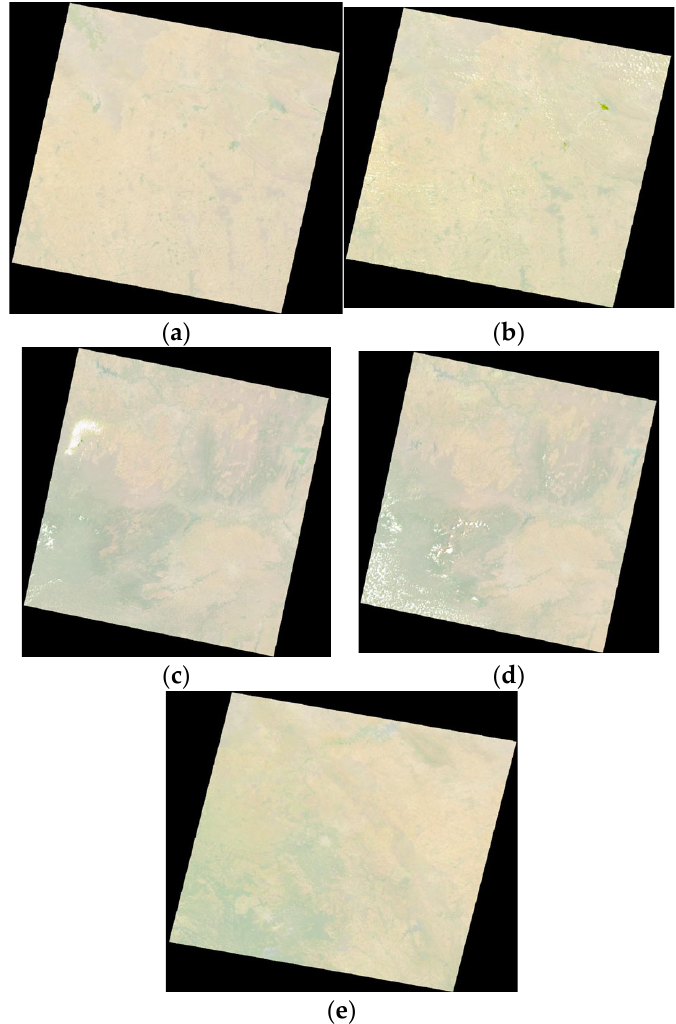
Figure 2. Samples for critical type of images ( a ) Dryland image ( b ) Capillary moisture image ( c ) Hygroscopic moisture image ( d ) Gravitational moisture image ( e ) Atmospheric moisture image.